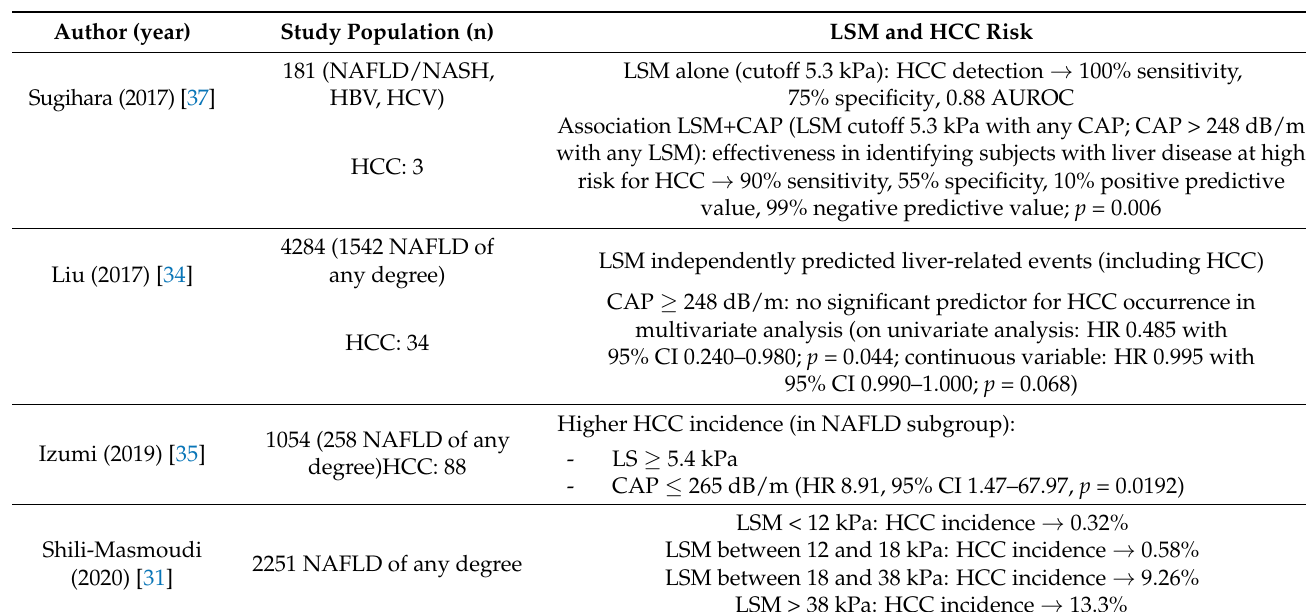
Table 2. The role of ultrasound liver stiffness measurement in predicting HCC risk in NAFLD